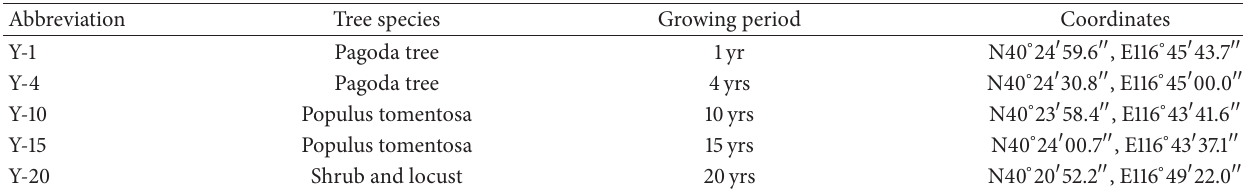
Table 1: Locations and afforestation information of the